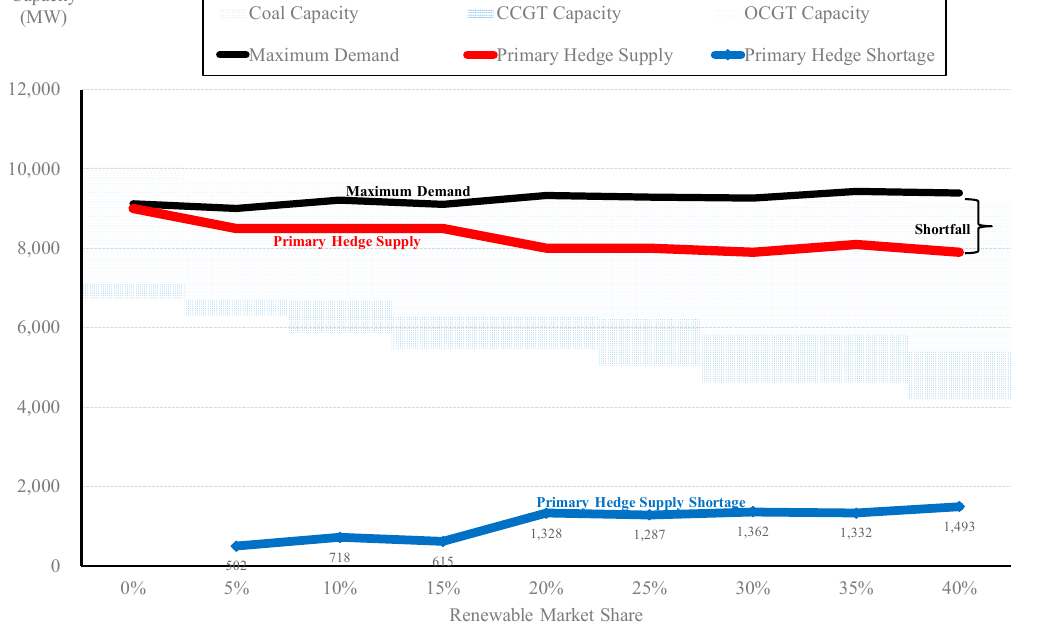
Figure 5. Primary supply of hedge contracts vs maximum demand (0%–40% VRE).